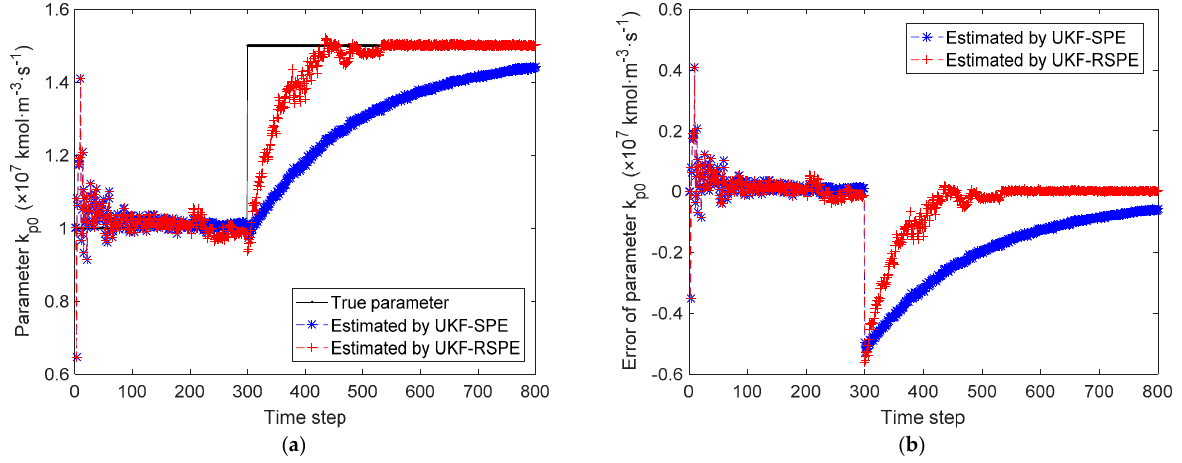
Figure 13. The comparison of the estimated results of parameter k p ,0 in Case Study 2.2: ( a ) estimated parameter; ( b ) parameter error.